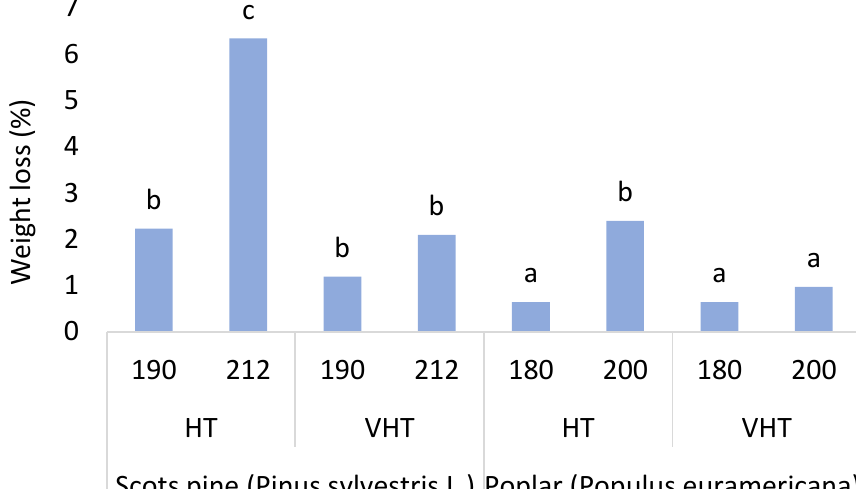
Figure 1. Weight loss (%) of heat and vacuum heat treated Scots pine and poplar wood. (The same letters on the columns denote no statistically significant differences between the groups.)